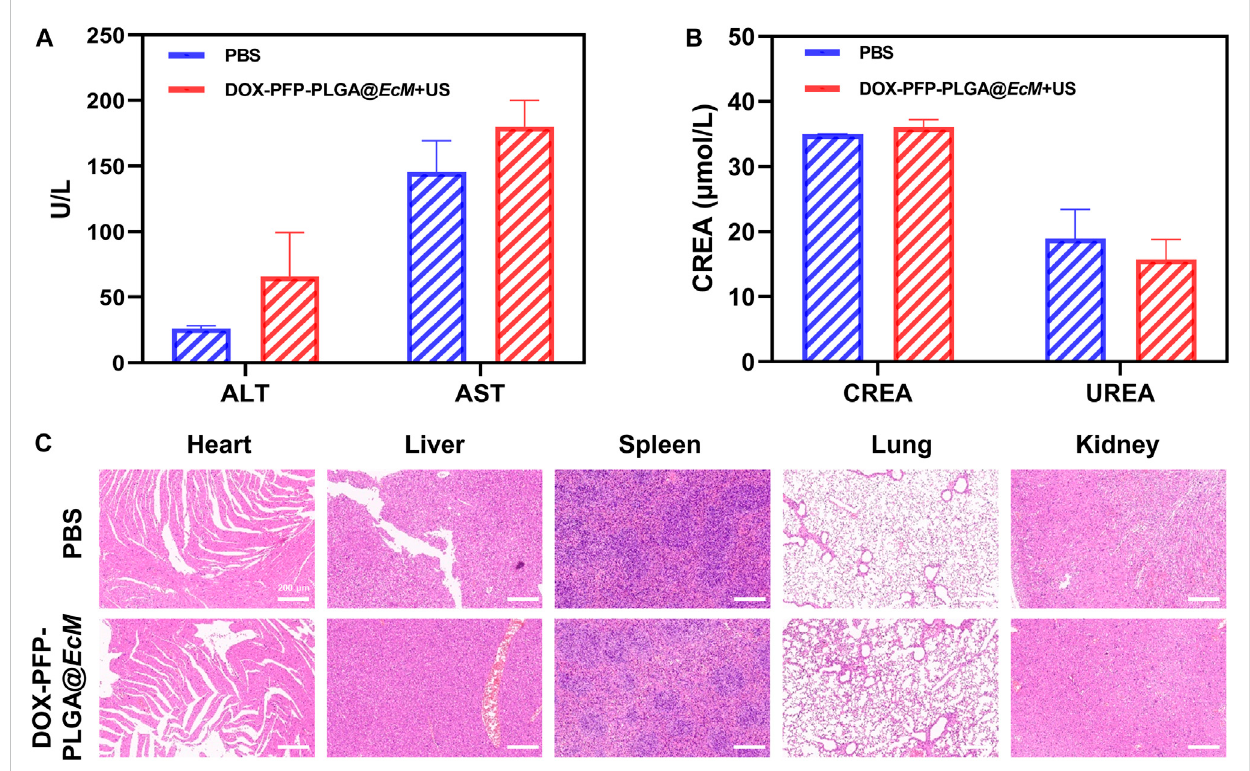
FIGURE 6 BiosafetyEvaluation. (A) SerumlevelsofALTandAST(liverfunction)( n =3). (B) Serumlevelsofcreatinine(CREA)andurea(UREA)(renalfunction, n = 3). (C) Histological analysis in vivo . H&E staining of heart, liver, spleen, lung, and kidney from the 4T1 tumor-bearing mice at 48 h after